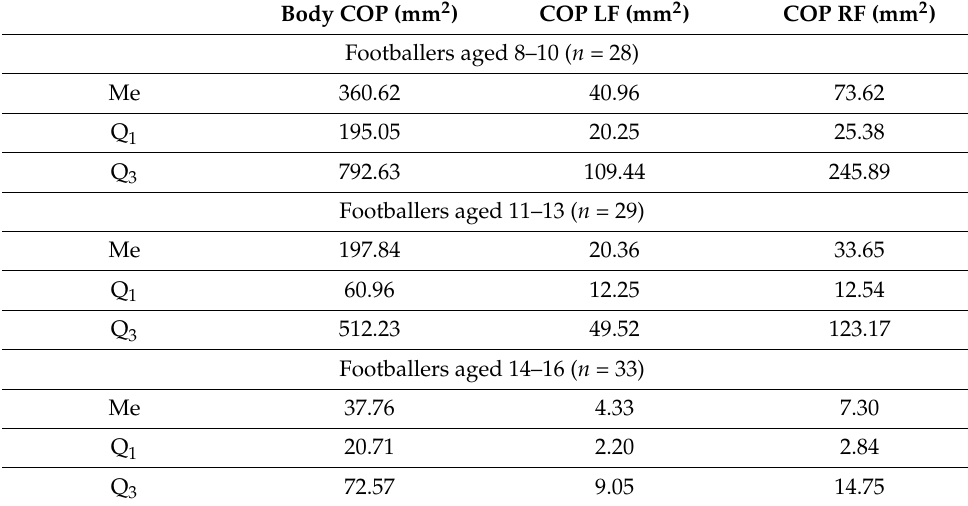
Table 2. Characteristics of the changes in the position of the center of gravity examination in the age‘groups.